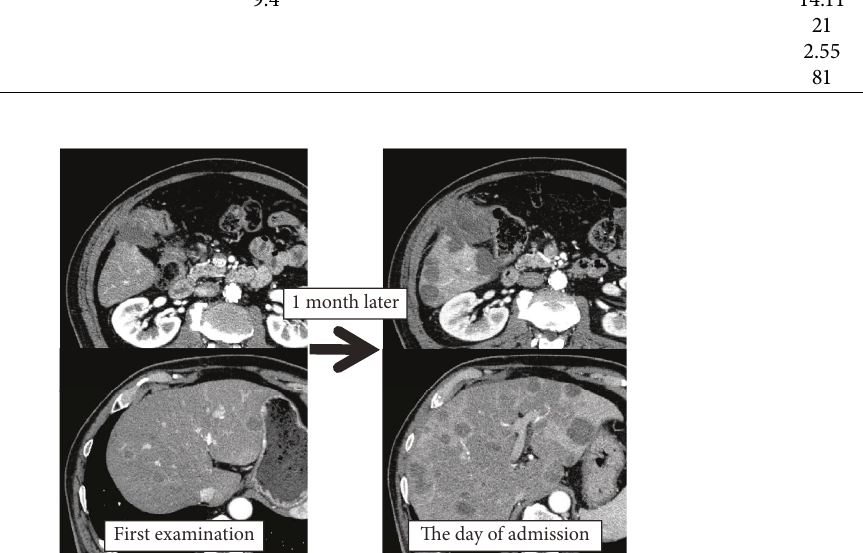
Figure 2: Contrast-enhanced CTon admission shows rapid progression of the primary tumor and liver metastases compared with that in the initial examination 1 month prior.